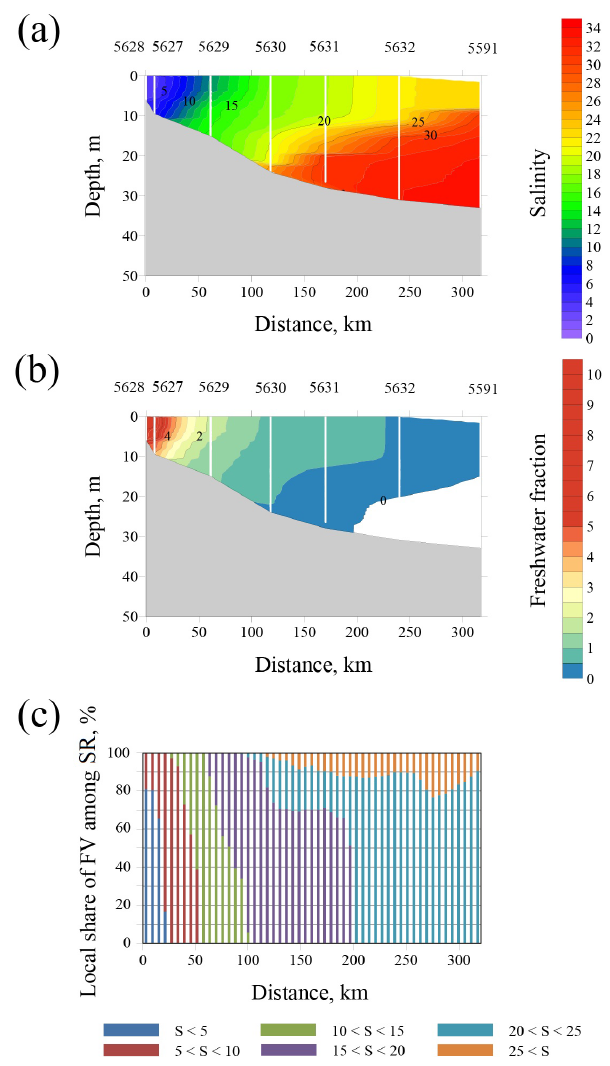
Figure 6. The vertical salinity structure (a) , distribution of freshwa- ter fraction (b) , local shares of FV among SRs in water column (c) along the ship track in the Khatanga Gulf and the adjacent shelf of the Laptev Sea on 17–18 September